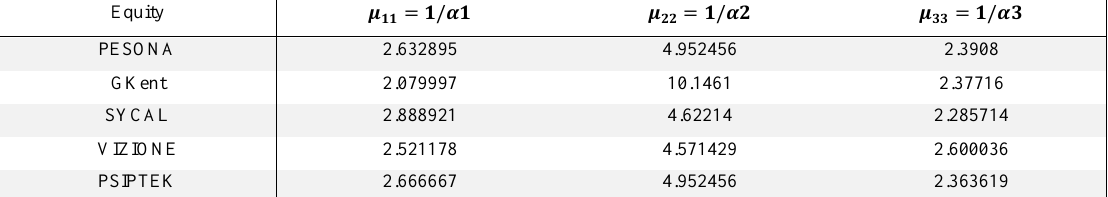
Figure 3. Mean recurrence time of selected shares for three-state Table 3. Expected return time for respective equities for three-state